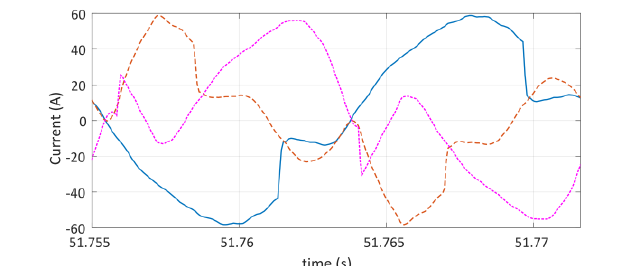
Fig. 10. Waveform in 𝑀 1 with 𝑇𝐻𝐷 𝑖 - 𝑆 𝐺 + 𝐼 𝐺 + 𝑁 𝐿 connected. Table XIII. Values in 𝑀 1 with 𝑇𝐻𝐷 𝑖 - 𝑆 𝐺 + 𝐼 𝐺 + 𝑁 𝐿 connected.